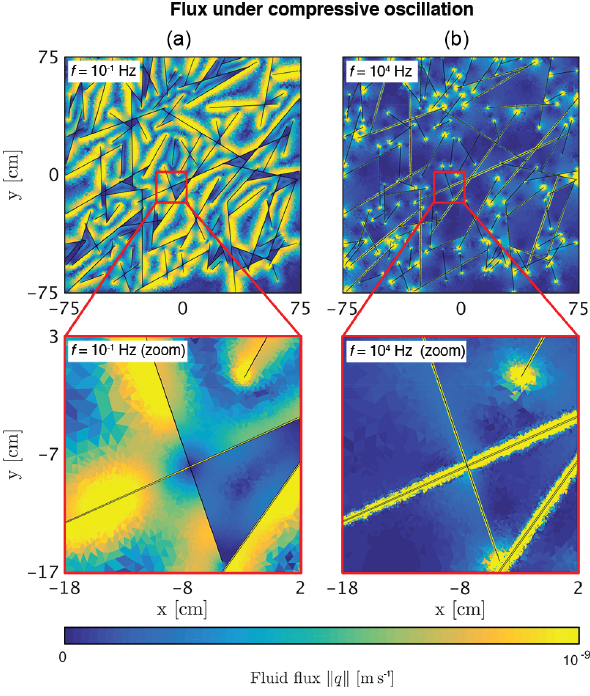
Figure 12. Amplitudes of pore fluid fluxes occurring under oscil- latory compression at 10 − 1 Hz (a) and 10 4 Hz (b) for the fractured rock properties corresponding to lithology B at a lithostatic stress of 15MPa (seismic properties for the same case are shown in Fig. 11a and c). Subplots at the bottom are enlarged views of specific regions in the top plots, marked with the red boxes.